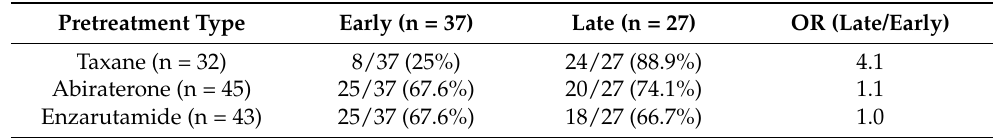
Table 5. Frequency of pretreatment type in Early and Late